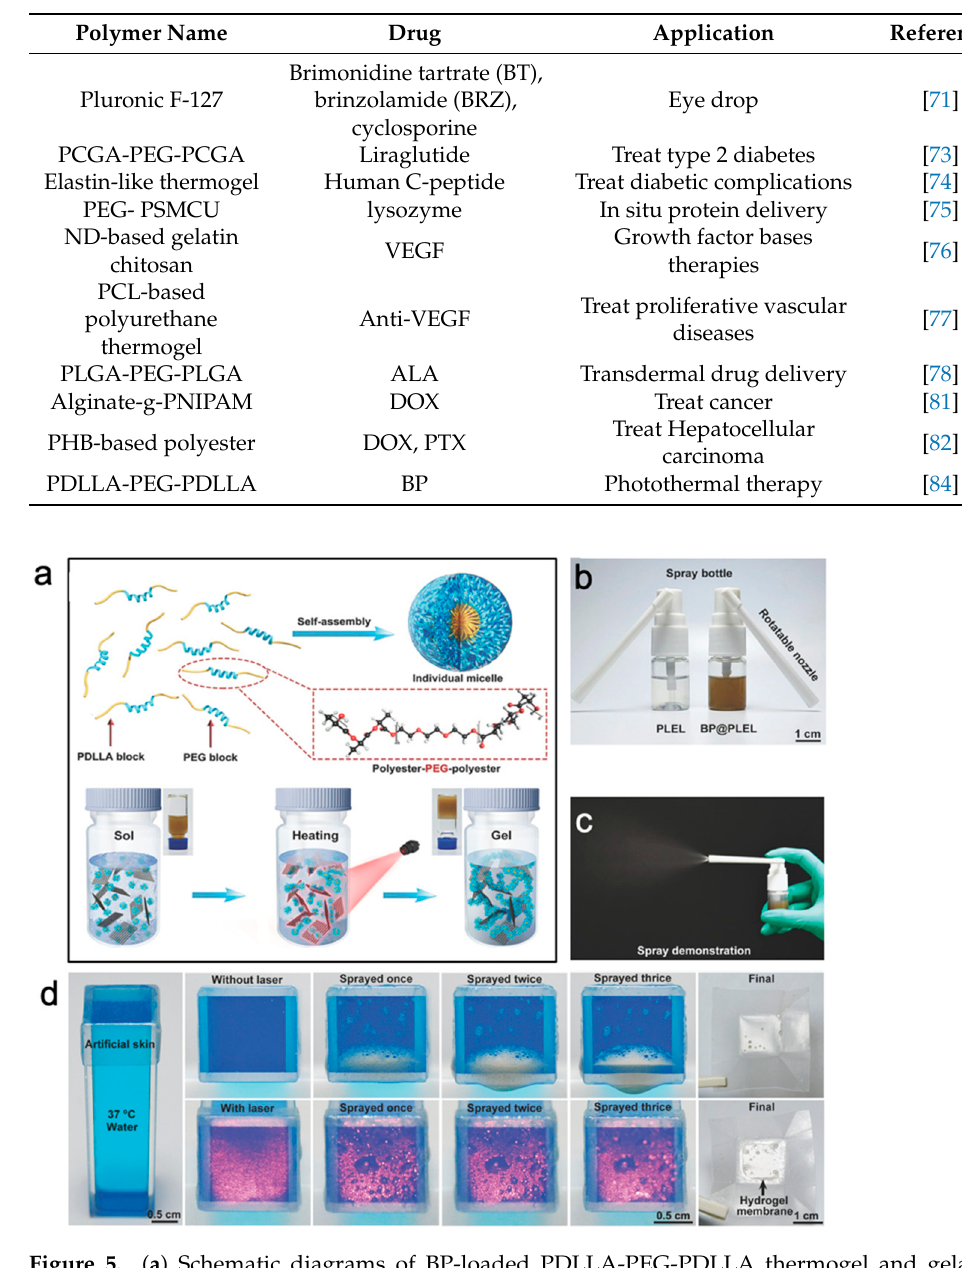
Figure 5. ( a ) Schematic diagrams of BP-loaded PDLLA-PEG-PDLLA thermogel and gelation upon irradiation with near-IR light. ( b , c ) Spray demonstration of PDLLA-PEG-PDLLA thermogel. ( d ) Sprayed gel rapidly forms gel layer on artificial skin after NIR irradiation, shown in bottom panel. Taken from